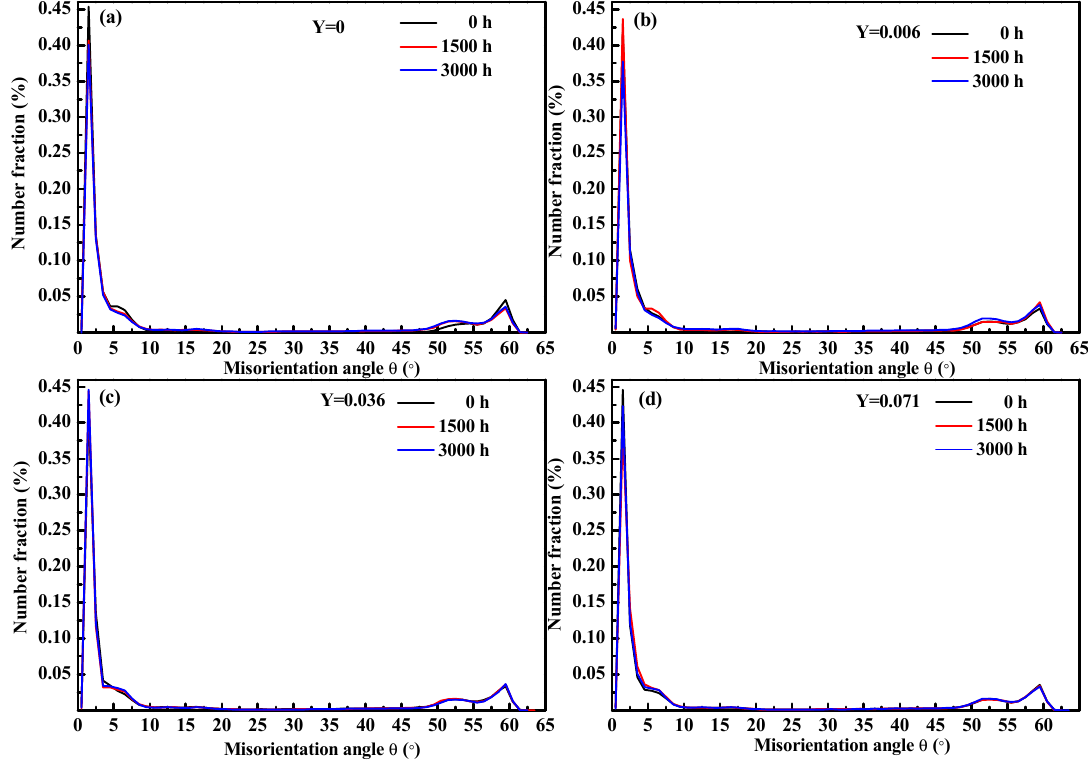
Figure 5. Distribution of misorientation angles in alloys during aging: ( a ) 0Y, ( b ) 6Y, ( c ) 36Y, ( d ) 71Y. Table 4. Statistical results for misorientation angles in alloys.